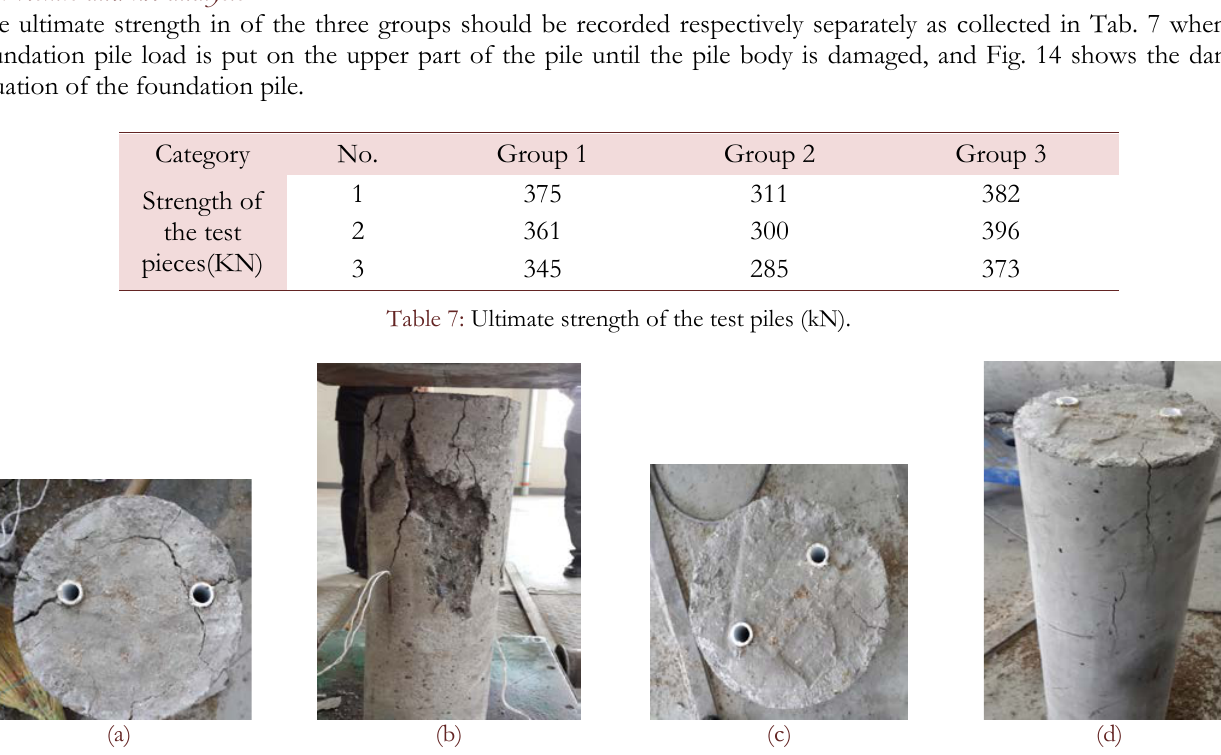
Figure 14: Damage situation of the pile body: (a) The end face of the pile with non-steel- fiber embedded pipes; (b) Non-steel- fiber pile without embedded pipes; (c) End face of the reinforced pile with steel fiber embedded pipes; (d) Reinforced pile body with steel fiber embedded